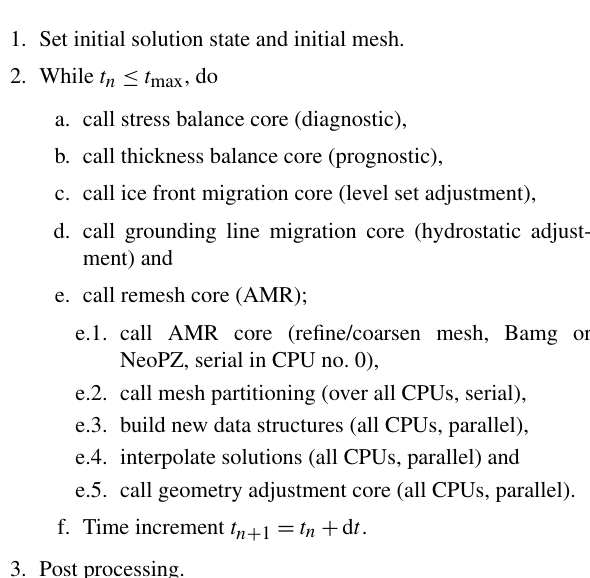
Algorithm 1 Transient simulation with